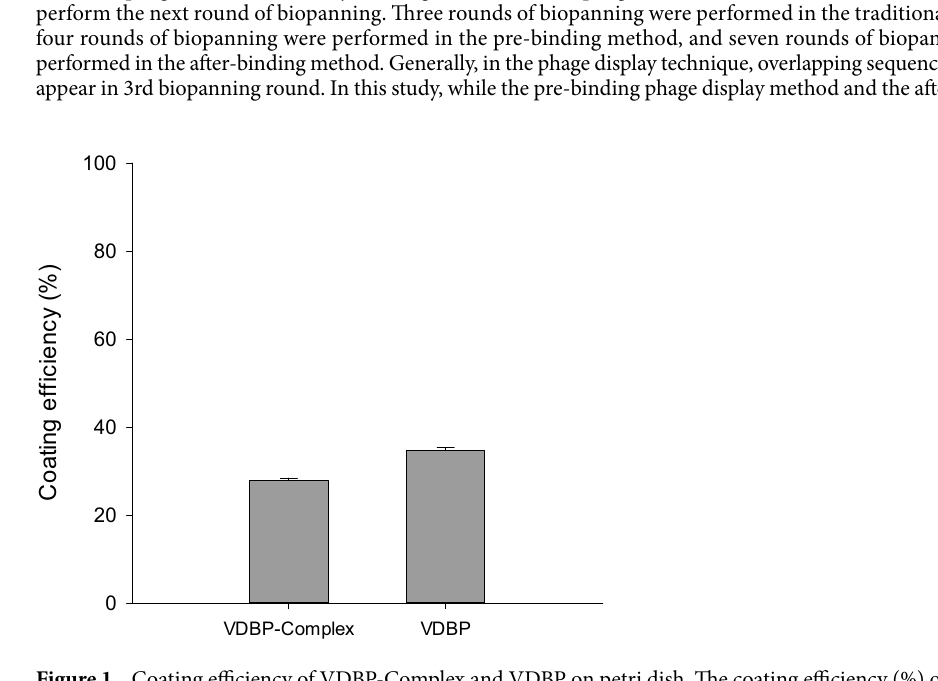
Figure 1. Coating efficiency of VDBP-Complex and VDBP on petri dish. The coating efficiency (%) of VDBP- Complex and VDBP. Each material concentration before and after the coating was measured by Bradford assay, and the coating efficiency was calculated and